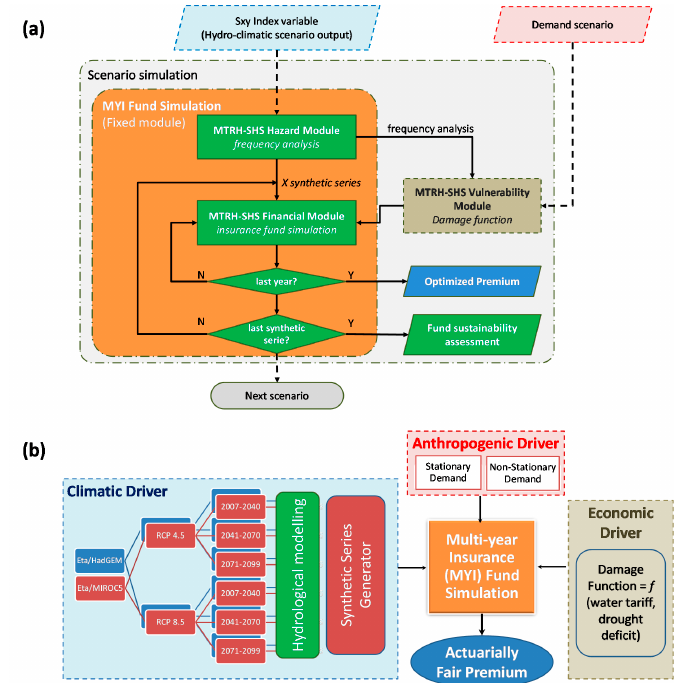
Figure 2. ( a ) Methodology flowchart linked to multi-year insurance (MYI) Modelo de Transferência de Riscos Hidrológicos of the Department of Hydraulics and Sanitation at Sao Paulo University (MTRH-SHS) fund simulator: climatic driver related to hydrological modeling, anthropogenic driver related to demand scenarios, economic driver related to tariff cost readjustment; ( b ) MTRH-SHS